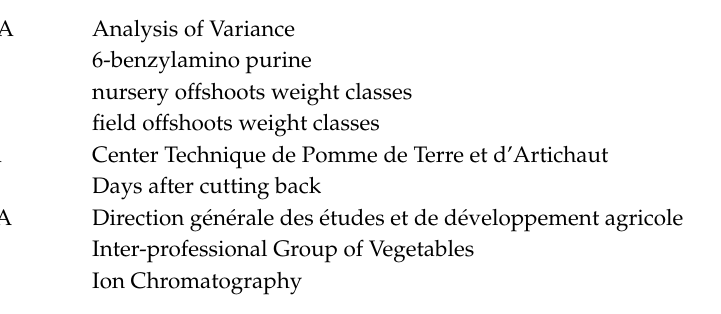
Table S1: Emission rhythm of offshoots from nursery plants according to 6-benzylamino purine (BAP) treatments; Table S2: Rhythm of offshoot emission per week according to 6-benzylamino purine (BAP) treatments applied on field mother